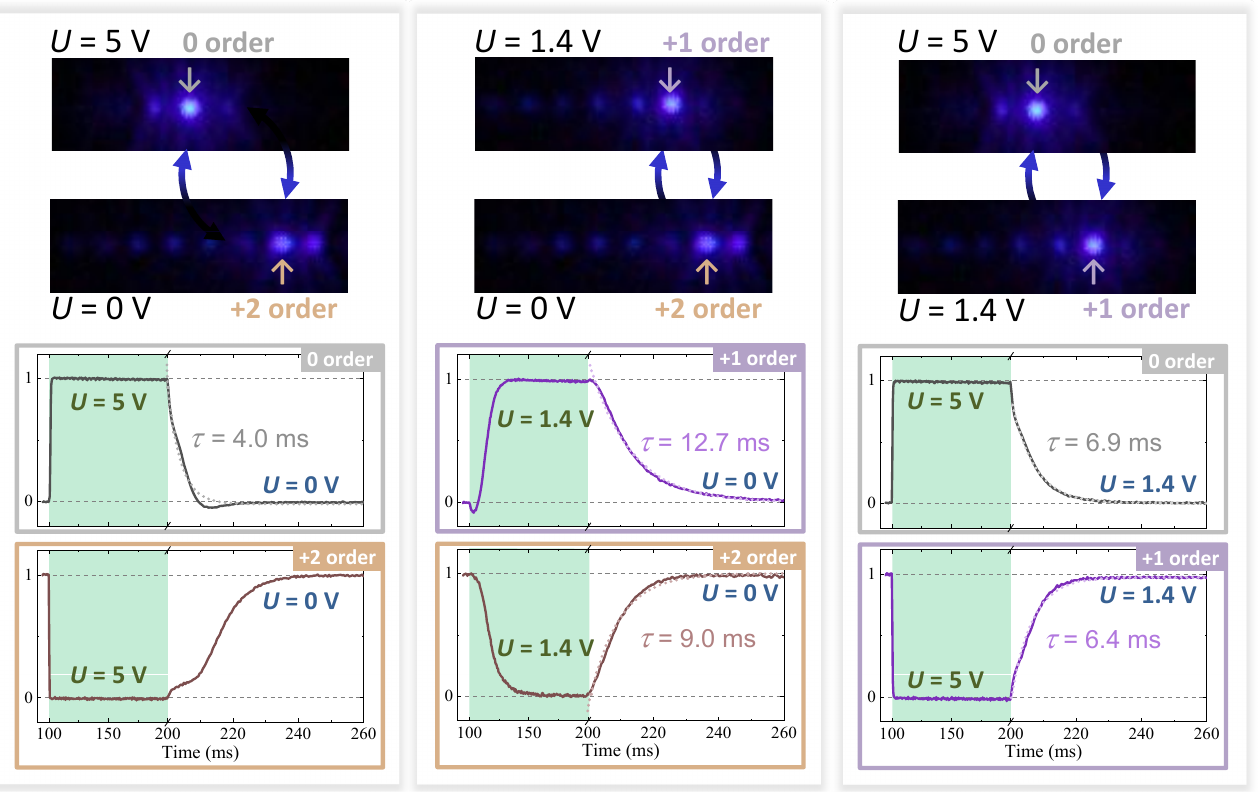
Figure 5. Switching dynamics of the 10 µ m periodic LC-metasurface between its three operation modes. Blue-light BFP POM images obtained at three voltages are shown with the dominant orders indicated. Normalized time-resolved intensity variation of the diffraction orders dominating in the corresponding modes are presented with the time intervals of 100 ms long rectangular switching voltage pulses indicated by light-green background. The best exponential fits of the relaxation dynamics are plotted as dotted lines and the corresponding relaxation times τ are